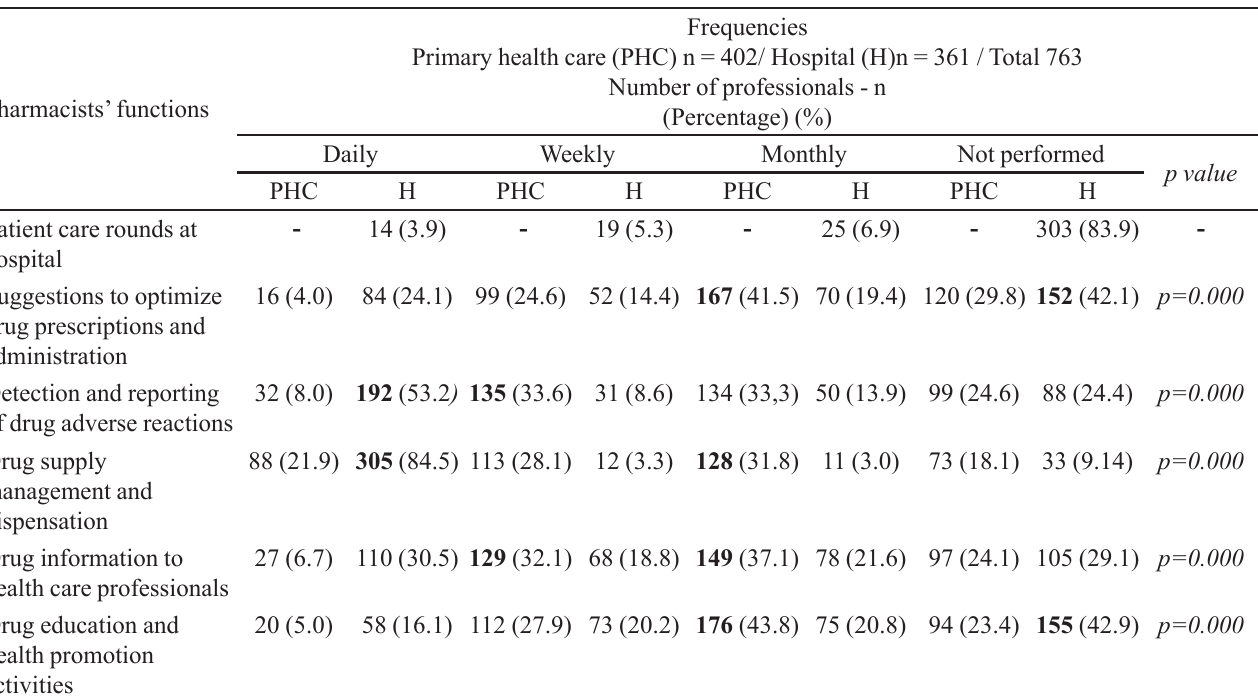
TABLE I - Participants’ perceptions of activities carried out by pharmacists in health care teams in different